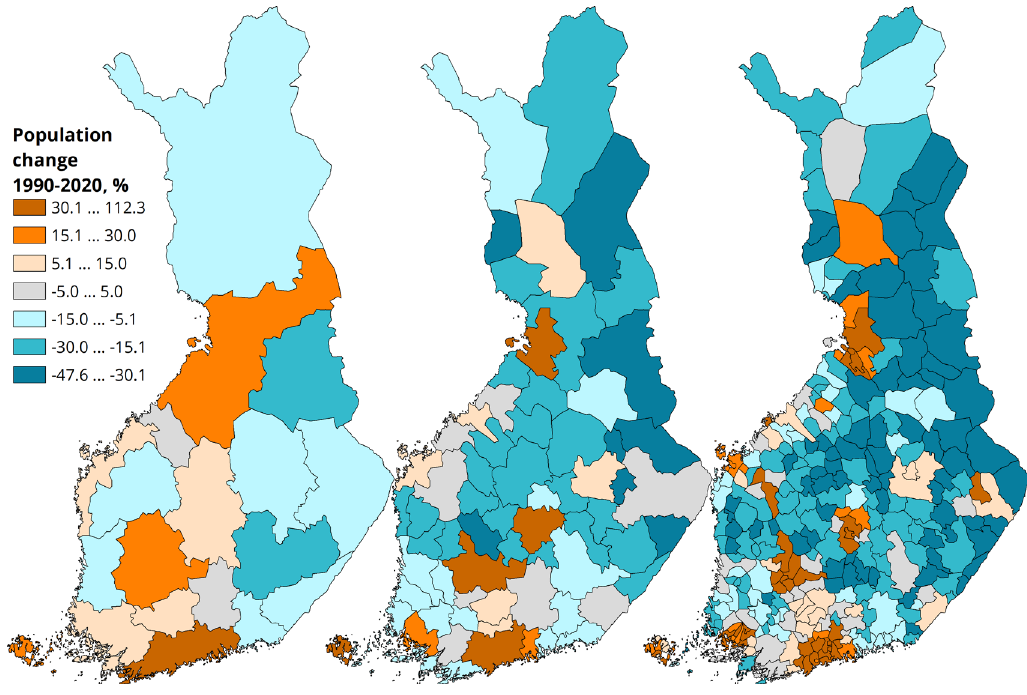
Fig. 2. Population changes of Finnish regions, 1990–2020.